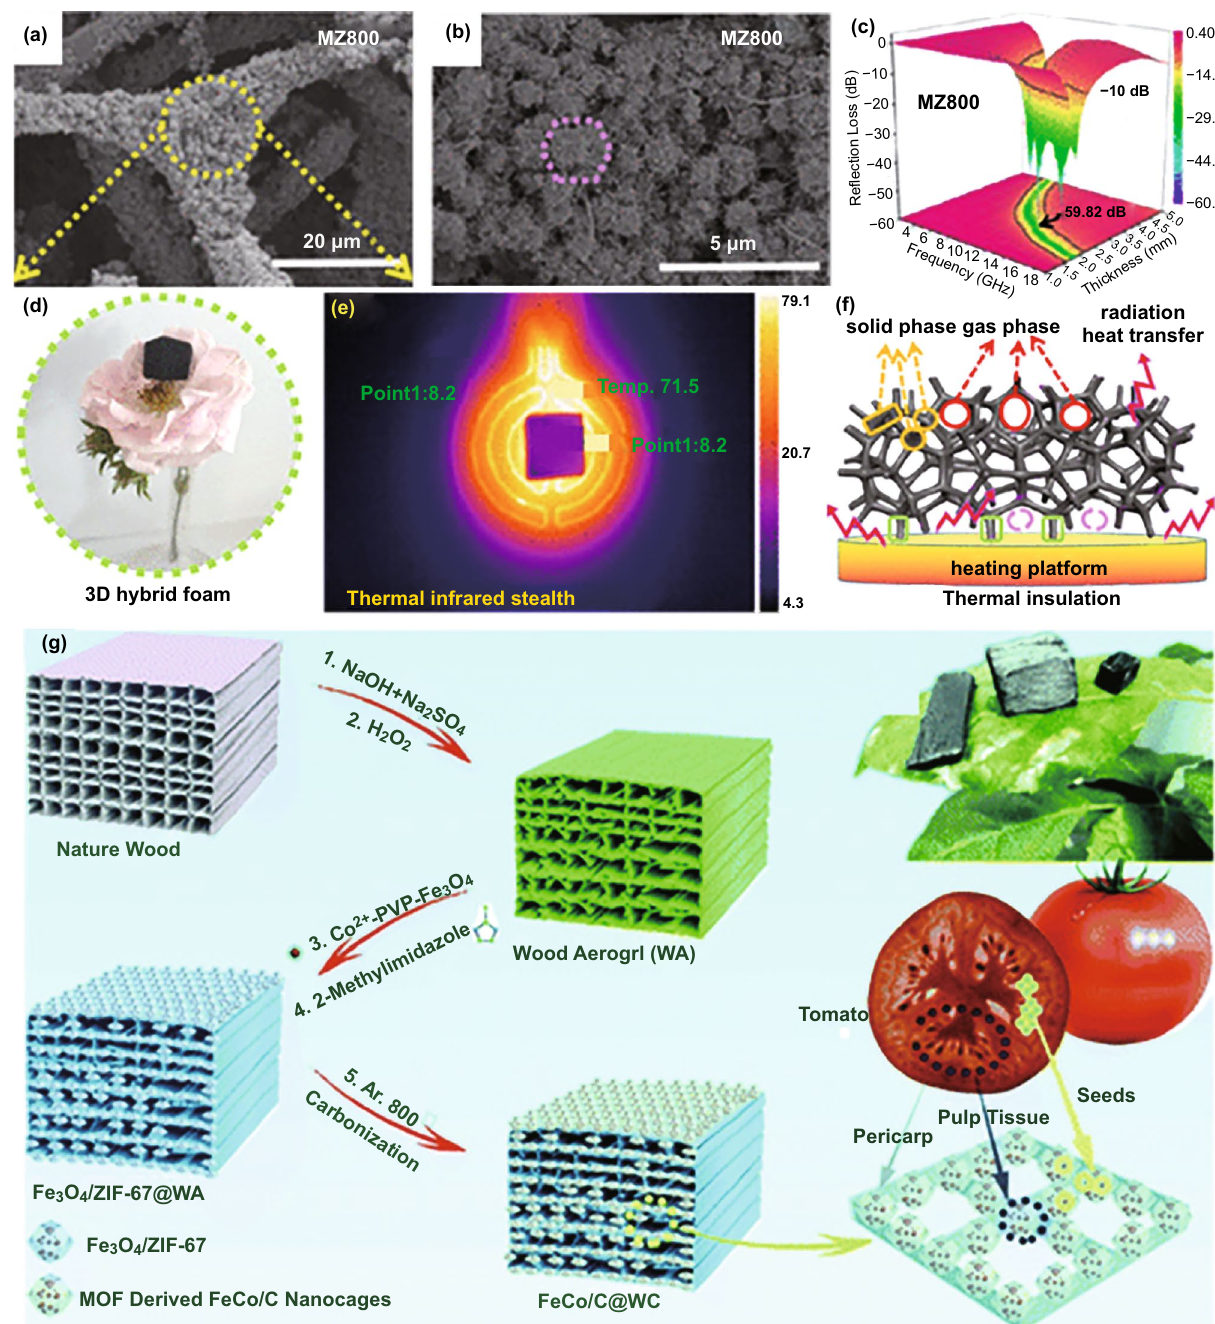
Fig. 10 a, b SEM images of MZ700, c 3D RL map of MZ800, d density test of MZ800, e thermal infrared images of MZ800 captured at 30 min, f schematics of the heat transfer mechanism. Reproduced with permission from Ref. [147] . Copyright © 2020 American Chemical Soci- ety . g Establishment of the tomato-like hierarchical porous FeCo/C@WC. Reproduced with permission from Ref. [154] . Copyright © 2020